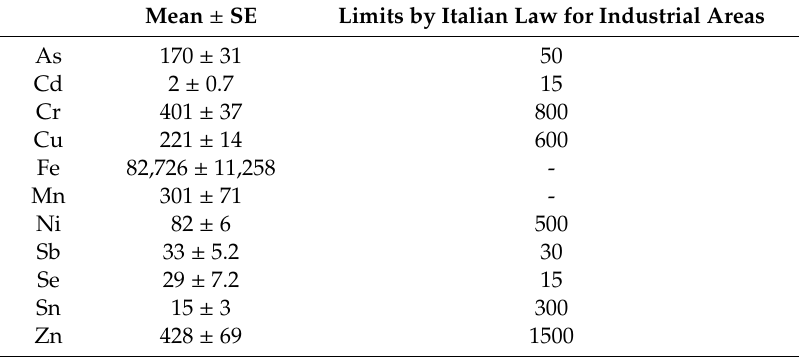
Table 1. Average concentration (mg / kg) of metals in the industrial soil. Number of replicas